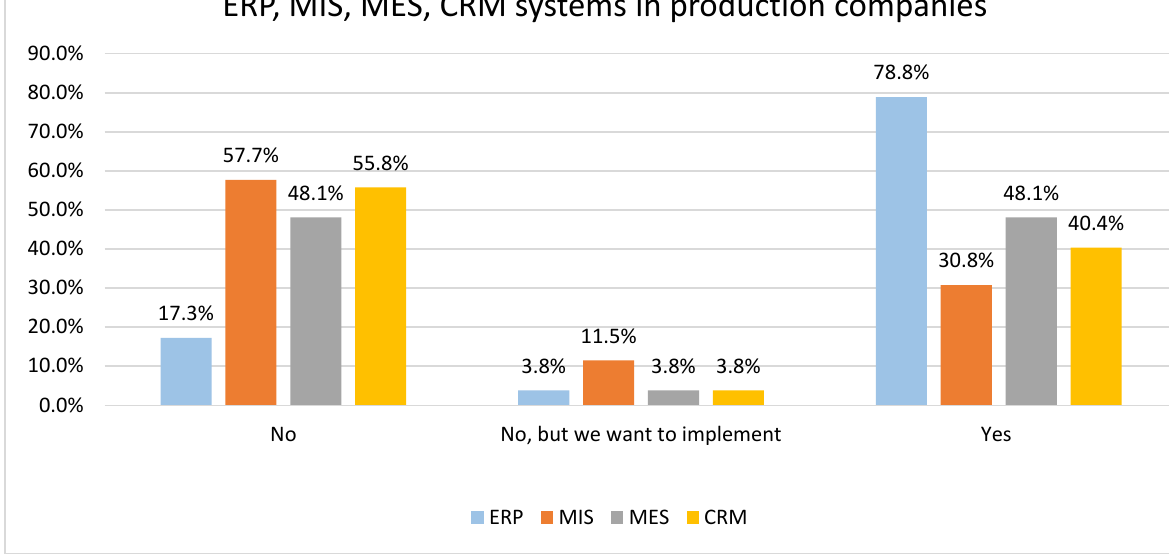
Figure 9. ERP, MIS, MES, CRM systems utilization in the studied companies. Figure 10 focuses on systems utilization in production companies. It can be seen that 78.8% of production companies have an ERP system implemented, and only 17.3% of pro- duction companies have no ERP system.